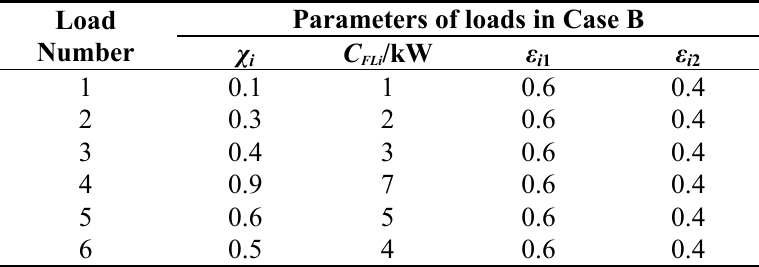
Table 2. Parameters of loads in Case B.